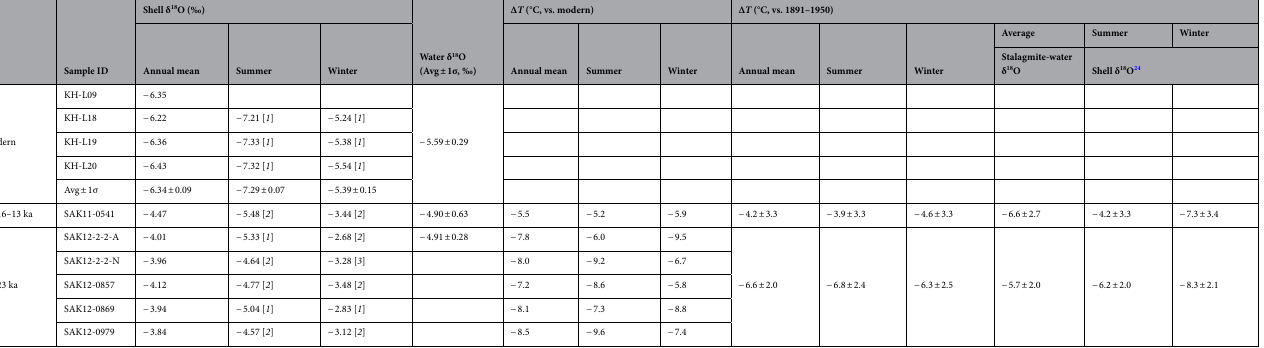
Table 1. Estimates of annual mean, summer, and winter temperatures at ca. 16–13 ka and ca. 23 ka. Italicized numbers within brackets denote the summer and winter shell δ 18 O data. Drip water and stalagmite inclusion water δ 18 O data represent spring water values. Temperature deviations were estimated from δ 18 O differences between the modern and fossil shells and waters, and from the coeval δ 18 O values of stalagmite calcite and fluid inclusion